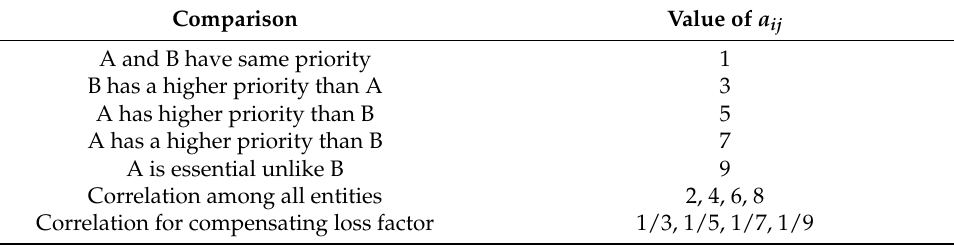
Figure 5. Fuzzy-based entity selection in IoT-based smart healthcare. Table 1. Parameter selection with fuzzy rule.